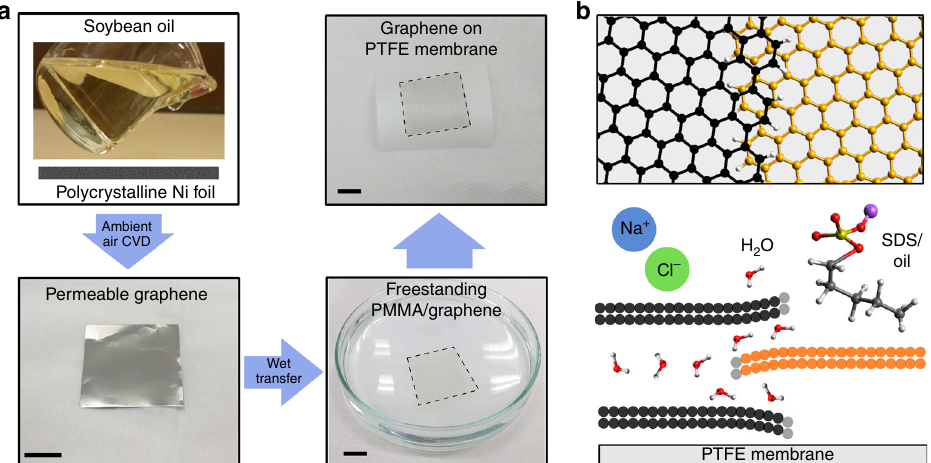
Fig. 1 Graphene fi lm synthesis for water desalination membranes. The schematic a illustrates the synthesis of permeable graphene using polycrystalline Ni substrate via the ambient-air CVD process using renewable sources such as soybean oil. The synthesised permeable graphene fi lm was transferred to commercial PTFE-based MD membrane for water desalination testing. The proposed mechanism of water puri fi cation and desalination is enabled by unique graphene features such as overlapping of graphene domains and grain boundaries b , as an advantageous feature in forming antifouling, long-term